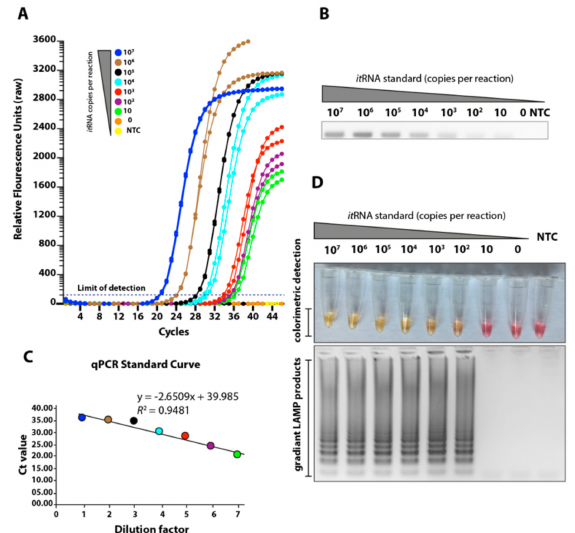
Figure 2. Sensitivities of the loop-mediated isothermal amplification (LAMP) assay. ( A ) Seven di ff erent dilutions of in vitro transcribed RNA were run for quantitative measurement using qRT-PCR. Relative fluorescence units show a gradient decrease in signals. ( B ) The corresponding PCR products on the electrophoresis gel. ( C ) The qRT-PCR standard curve based on the Ct value and dilution factor. ( D ) The serially diluted synthetic RNAs were run in the LAMP assay and colour change represents positive (yellow) or negative (pink). The lower panel shows the LAMP gradient